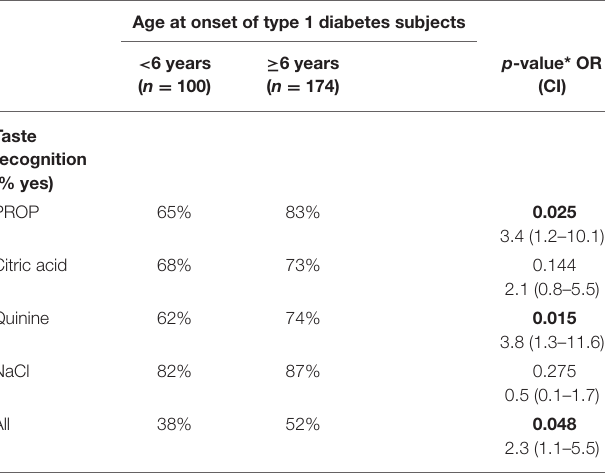
TABLE 3 | Taste recognition accordingly age at